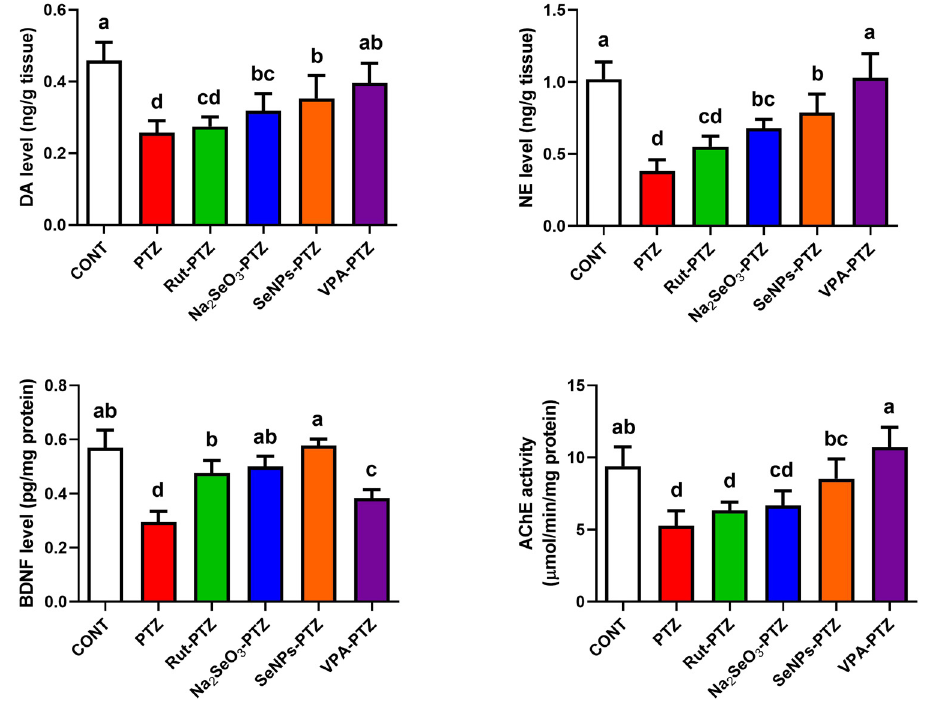
Figure 3: E ff ects of orally administered Rut, Na 2 SeO 3 , or Rut - SeNPs on the levels of dopamine, NE, BDNF, and AChE activities in the hippocampus of PTZ - injected epileptic mice. Di ff erent superscript letters indicate statistical signi fi cance at P < 0.05. All results are presented as the mean ±